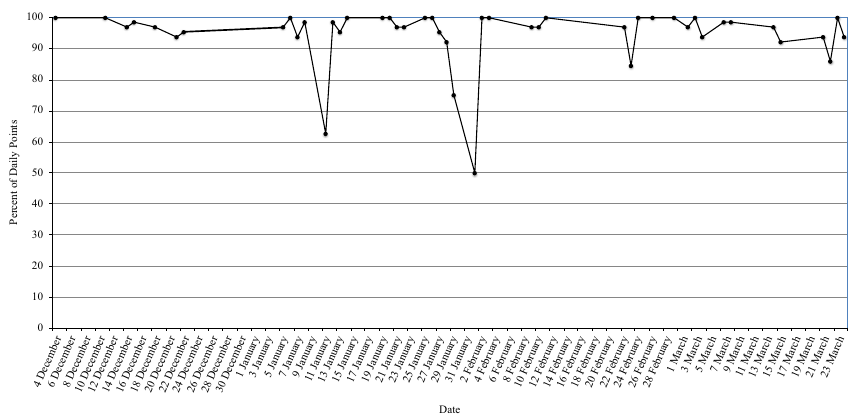
Figure 2. Check-in/check-out progress monitoring data for “ Jessica